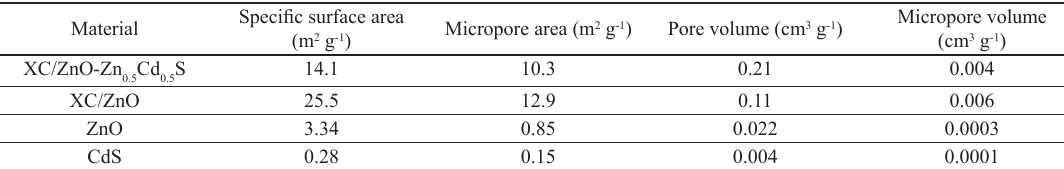
Figure 7. a) Nitrogen isotherms for the ZnO, CdS, and XC/ZnO-Zn ZnO-Zn Cd S. 0.5 0.5 Table 2. Morphological parameters obtained for the